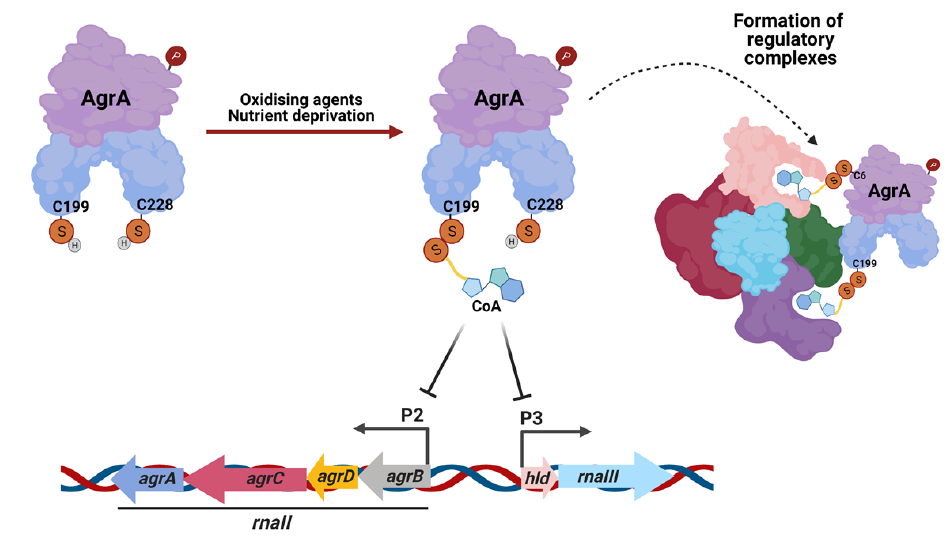
Figure 6. Schematic representation of the effect of AgrA CoAlation on DNA binding at P2 and P3 promoters. Upon oxidative stress or nutrient deprivation, AgrA is CoAlated at Cys199, which inhibits its DNA-binding to P2 and P3 promoters. CoAlation of AgrA may promote the formation of regulatory complexes through the recognition of the ADP moiety of CoA by proteins containing the Rossmann binding fold, which might be involved in the activation of antioxidant response elements. (Created with BioRender.com (accessed on 21 May 2021)).